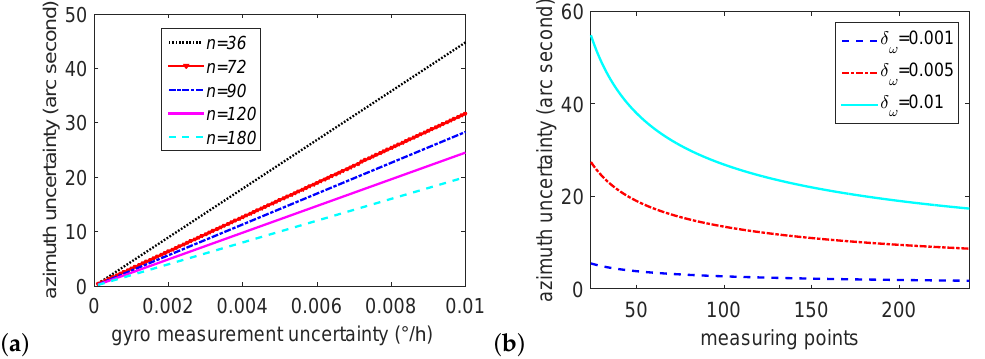
Figure 6. The relationship of the azimuth uncertaintyagainst the gyro random drift and the measuring points. ( a ) The azimuth uncertainty against random drift at various points n ; ( b ) The azimuth uncertainty against random drift at various values of σ ω